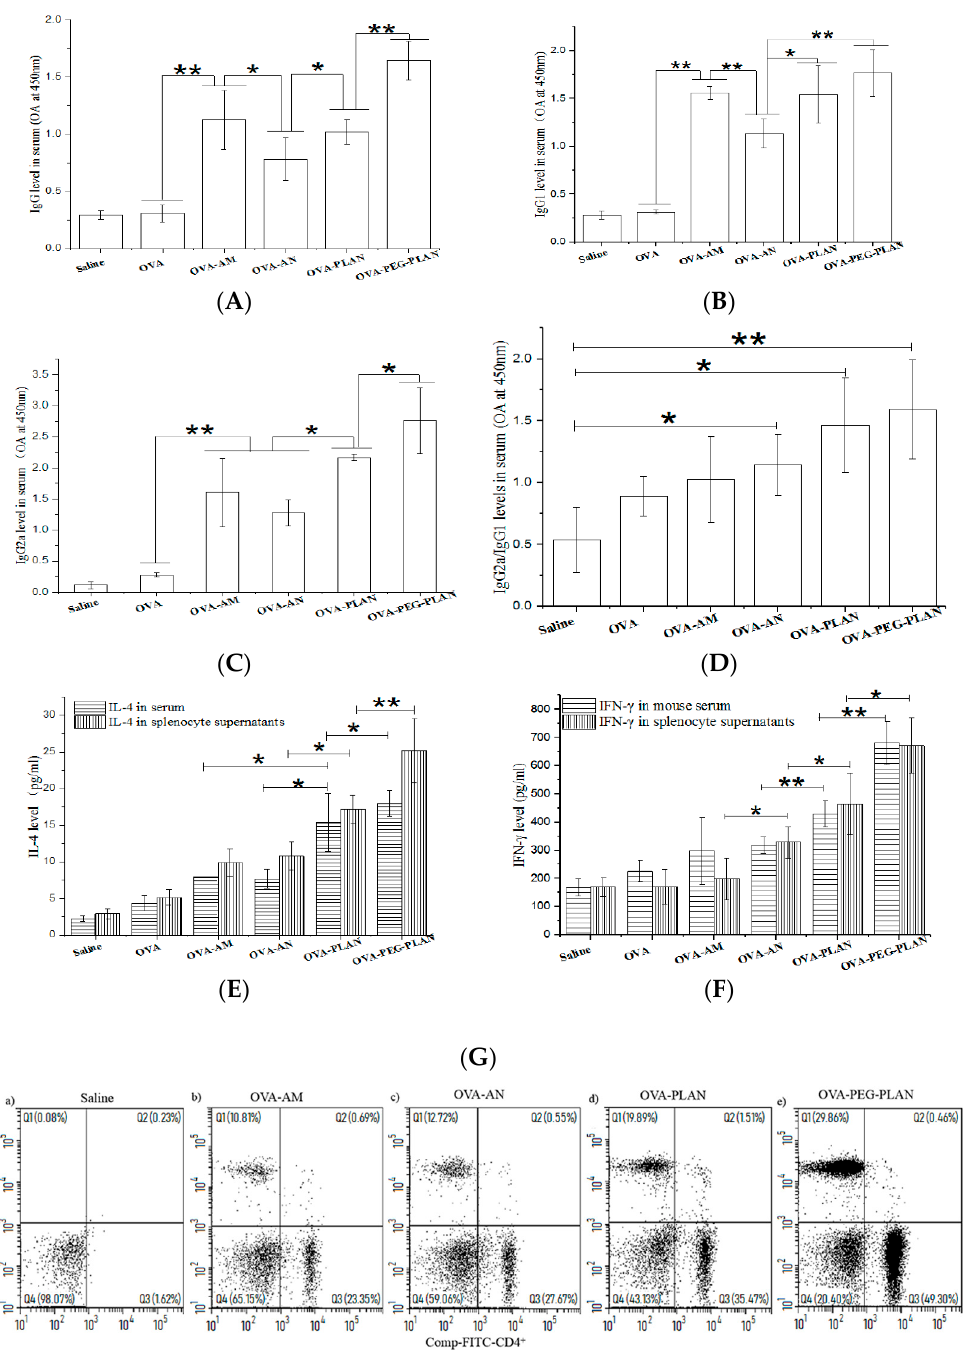
Figure 5. The Ag-specific immunity established in mice elicited by subcutaneous vaccination with Al-based carriers ( n = 6). ( A – C ) The titer levels of IgG, IgG1, and IgG2a in mouse sera detected three weeks after immunization with different formulations. ( D ) The ratio of IgG2a/IgG1 in mice immunization with different formulations. ( E , F ) The levels of IL-4 and IFN- γ in mouse sera and blood of mice immunization with different formulations. ( G ) The frequency of CD4+ T and CD8+ T lymphocytes in spleens of mice immunization with different formulations. (* p -value < 0.05, ** p -value < 0.01).